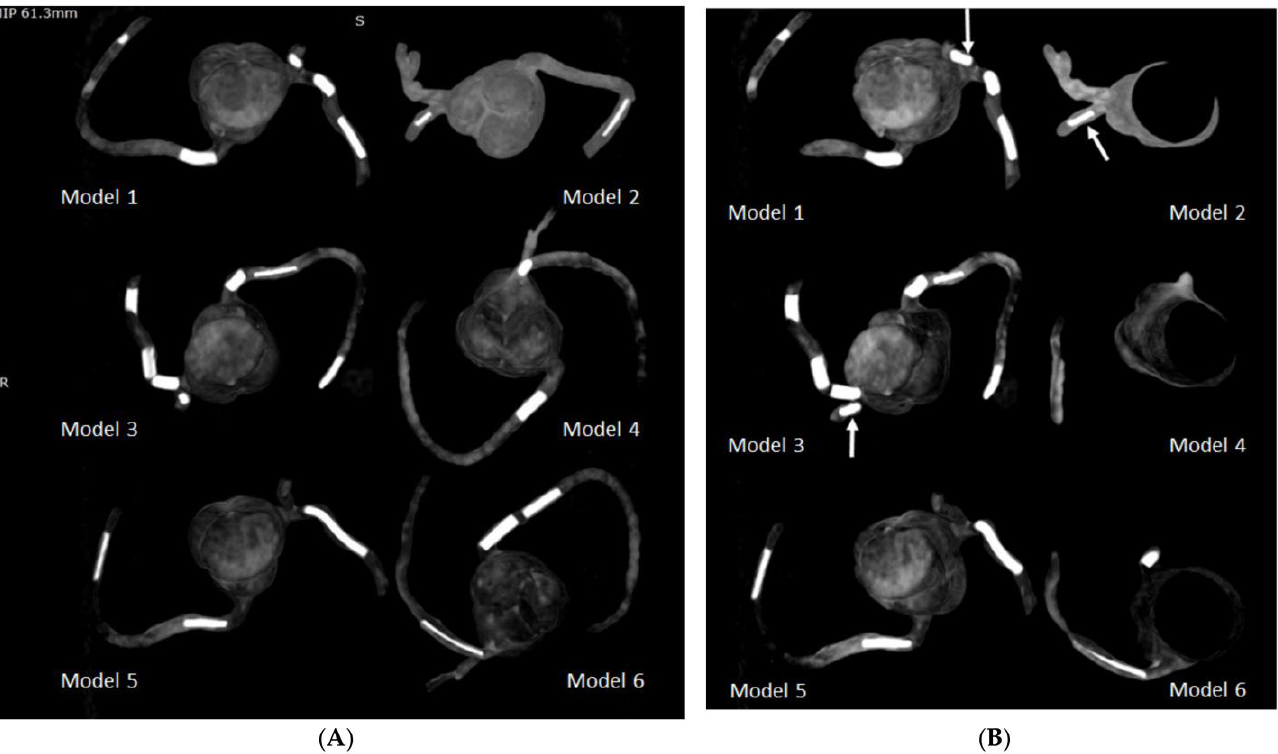
Figure 11. Maximum-intensity projection (MIP) images showing the calcified plaques in six 3D- printed coronary models. ( A ): Coronal MIP view showing these calcified plaques. ( B ): Oblique MIP view showing the plaques more clearly in the left circumflex coronary artery (arrows) in Model 1 (plaque 3), Model 2 (plaque 6) and Model 3 (plaque 11). Reprinted with permission under the open access from Sun et al. [53].